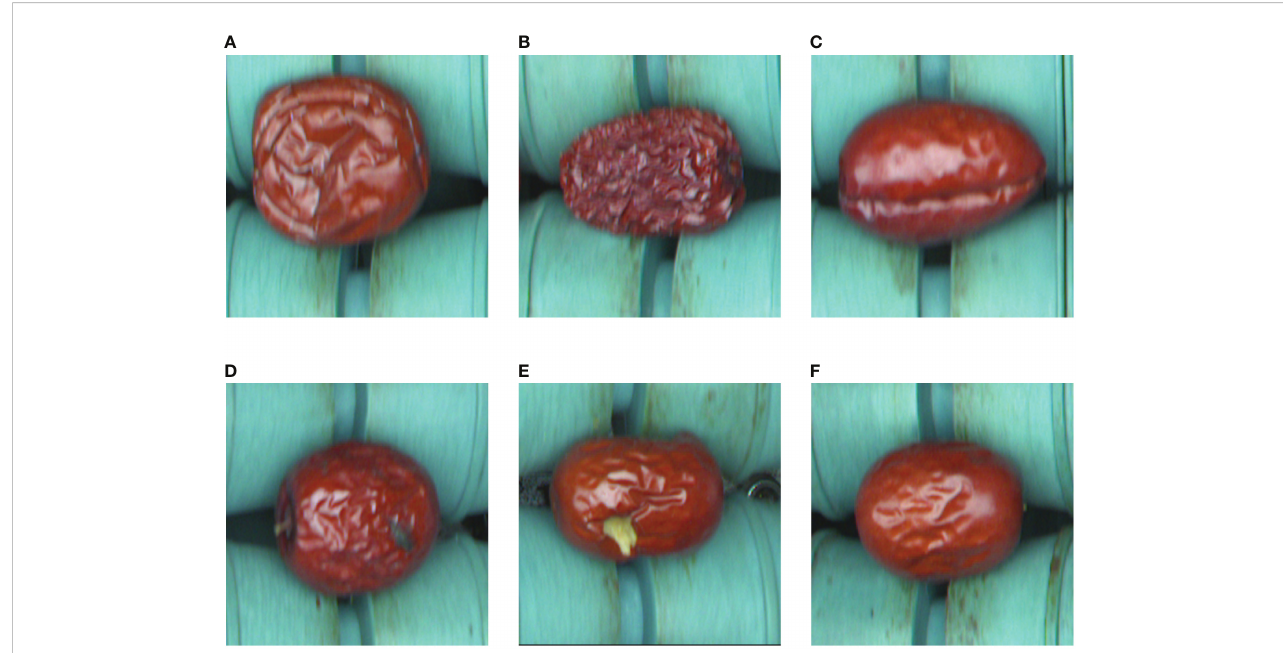
FIGURE 2 Examples of six kinds of defect samples: (A) deformed; (B) wrinkled; (C) cracked; (D) moldy; (E) bird-pecked; (F) normal. (A-E) are jujubes with surface defects, and (F) is one of high